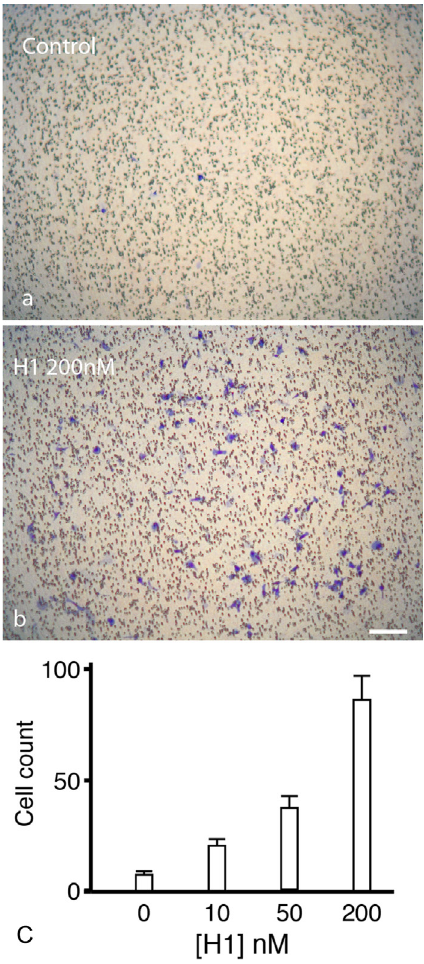
Figure 8. Histone 1 upregulates MHC class II expression in microglia. ( a ) Primary microglial cultures were incubated in serum- free medium for 24 hrs and identified with Iba1 (red). ( b ) Cultures were then treated with histone H1 (100 nM) for 24 hrs. Activated microglia were identified with OX-6 (which labels MHC-class II, green) so that double-stained cells appear yellow. Scale bars: 100 μm. ( c ) Histone H1 dose-dependently increased the expression of MHC class II to a level similar to that elicited by LPS (1 μg/ml). 25 nM H1 produced a 6-fold increase in expression of OX-6 (p<0.001) while the effects of 50 nM histone H1 were not different from the maximal response to LPS at 1 μg/ml. Error bars represent ± SEM for all conditions, one-way ANOVA, Bonferroni post-hoc correction.